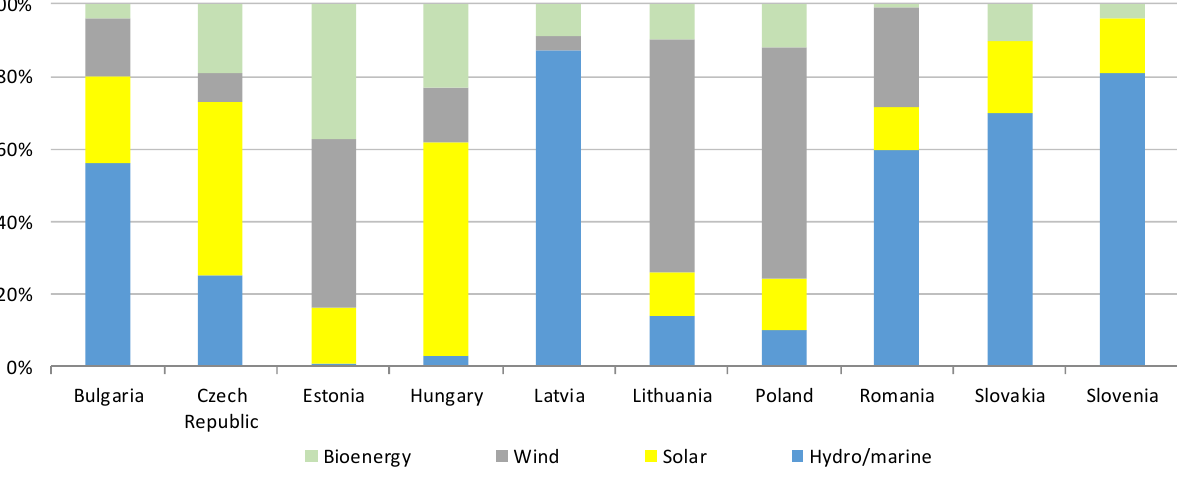
Figure 2. Electricity capacity structure obtained from RES (in %) in 2019.